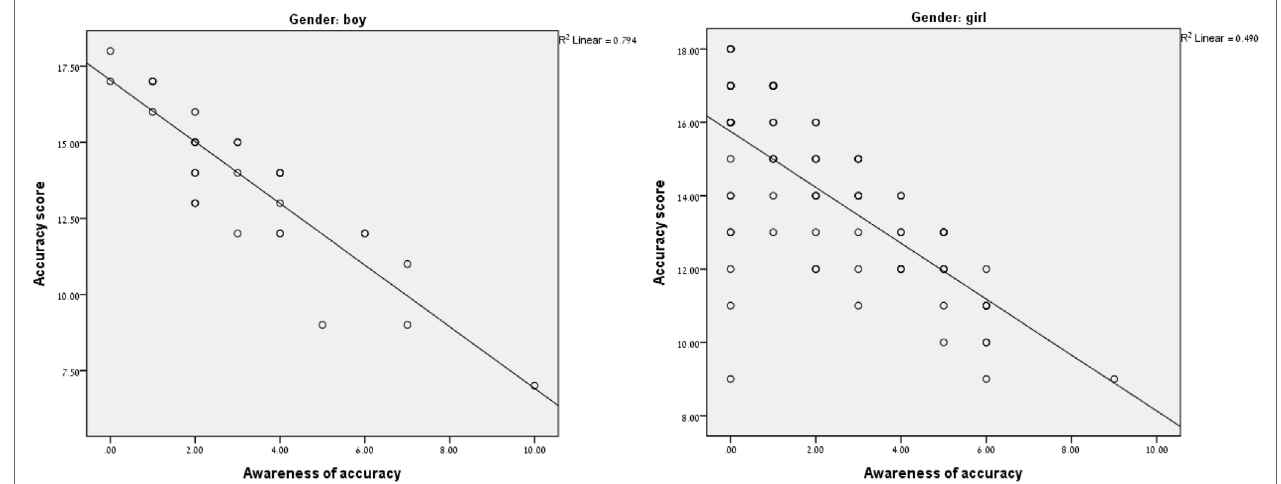
FigUre 1 | Correlations between the Weekly Calendar Planning Activity awareness score and the accuracy score for girls ( n = 78) and boys ( n =